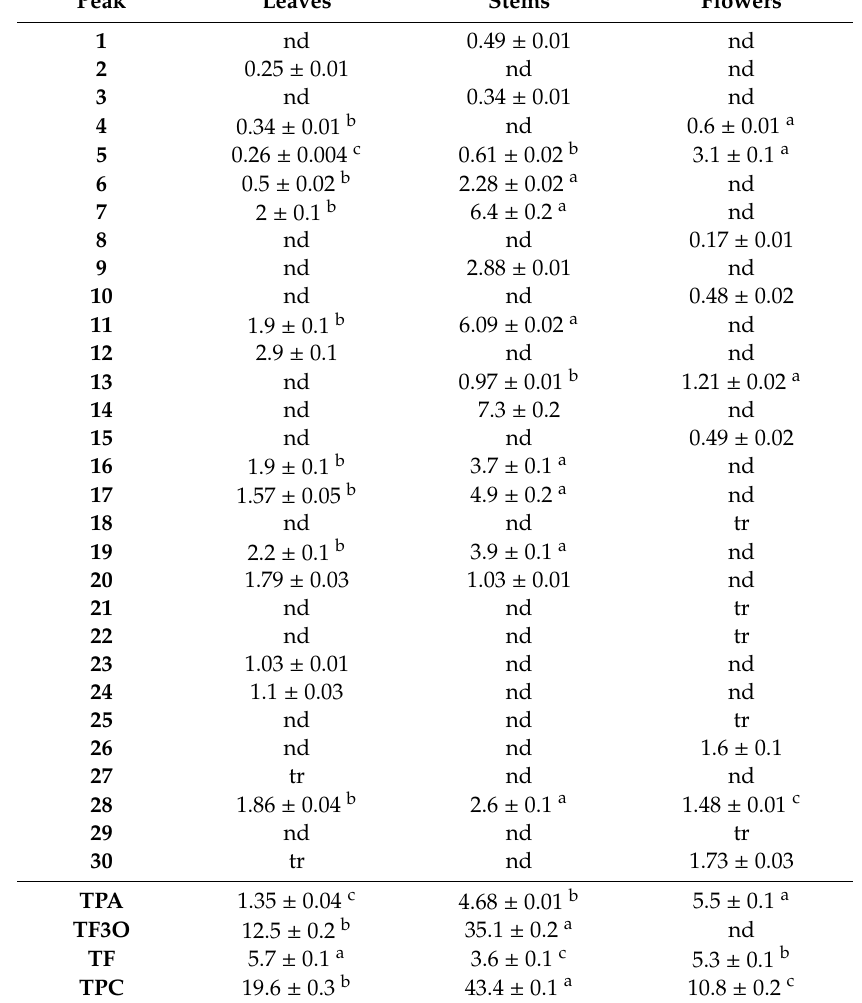
Table 2. Quantification (mg / g of extract) of the phenolic compounds present in the hydroethanolic extracts of C. macrocarpa leaves, stems, and